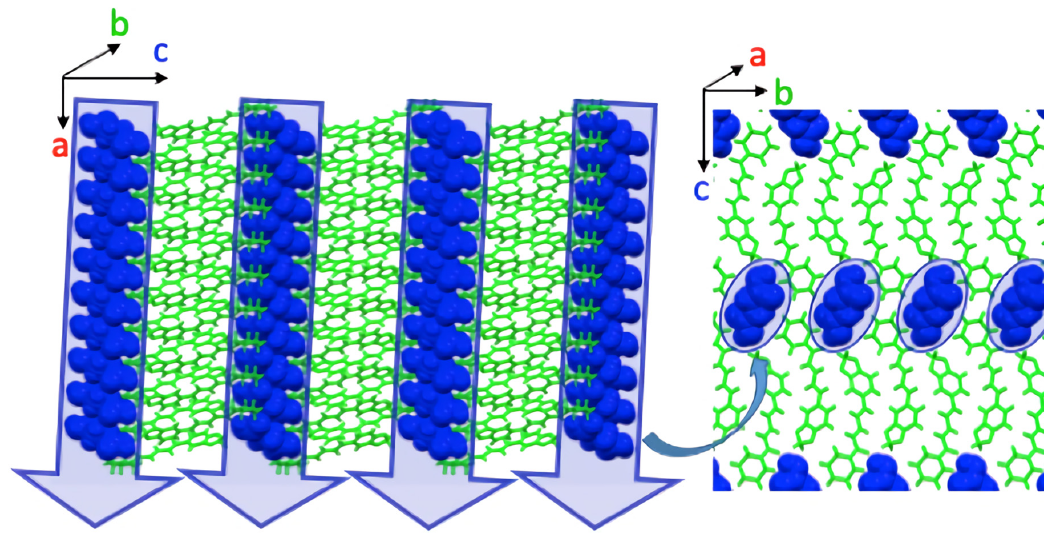
Figure 6. Channel motif of the succinic acid cocrystal (green, piperine; blue, succinic acid) with a-, b-, c-axis mark.